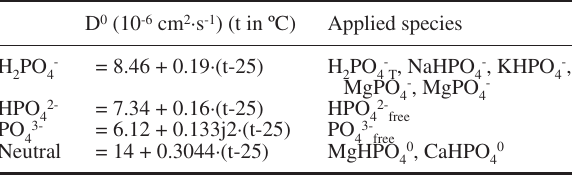
Table 2. – Diffusion coefficient at infinite dilution (D 0 ) of each species of phosphoric acid equilibrium and applied